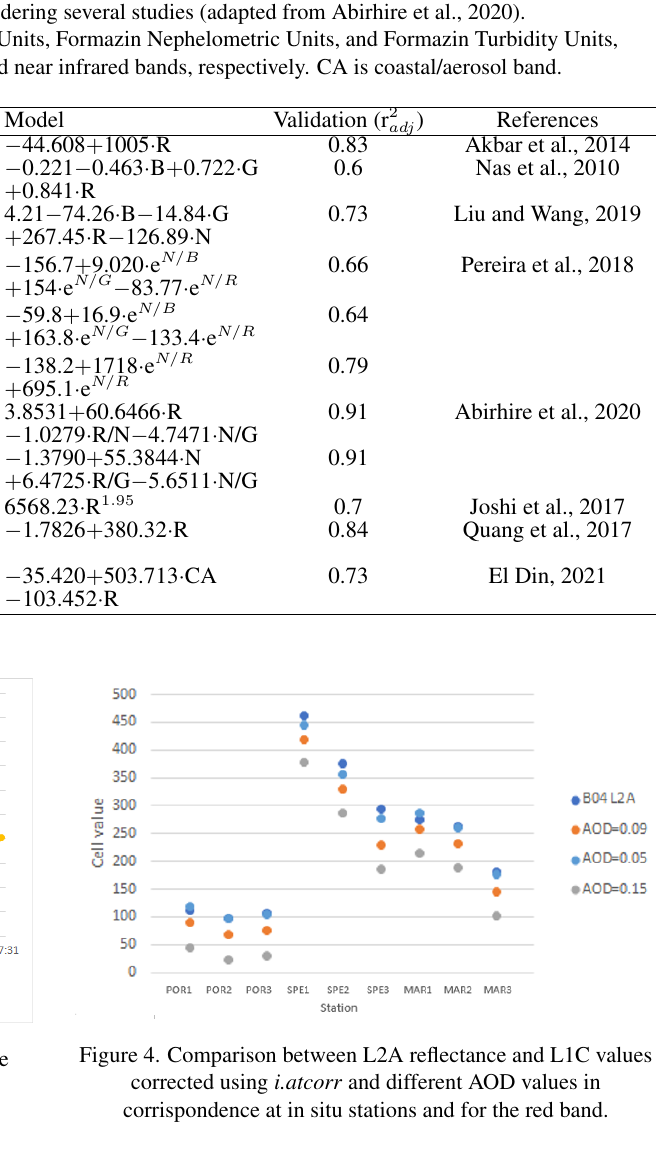
Cirrus correction: “true”, so to apply the